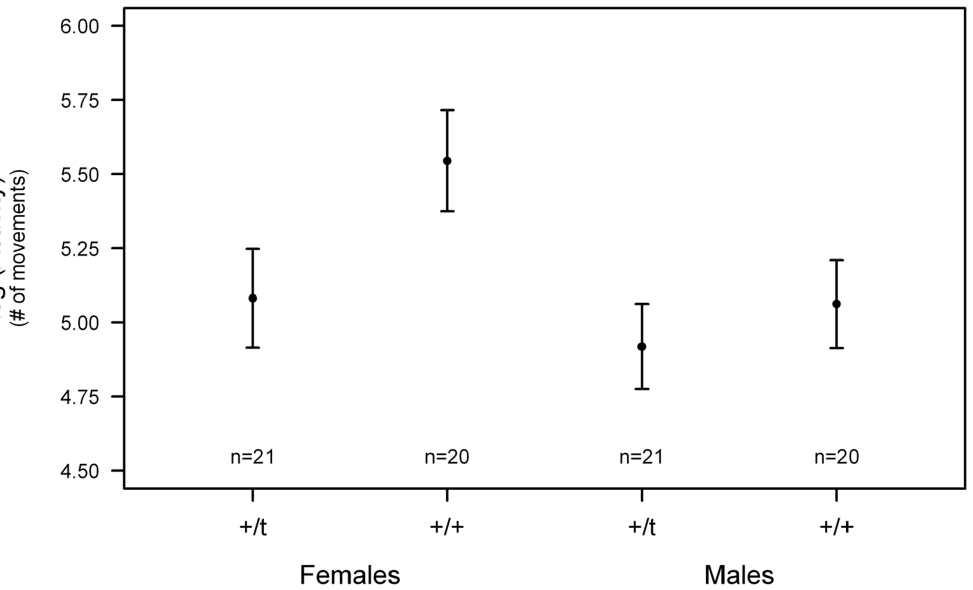
Figure 2. Effect of the genetic background and sex on activity score (mean ± standard errors predicted by mixed effect model). doi:10.1371/journal.pone.0067130.g002 PLOS ONE |